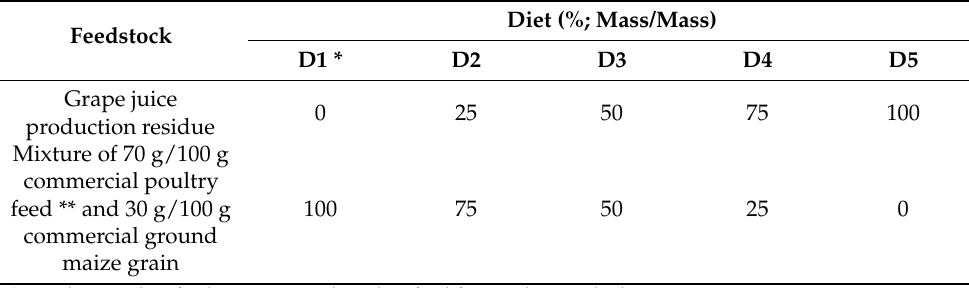
Table 6. Diet formulation and coding for feeding Zophobas atratus